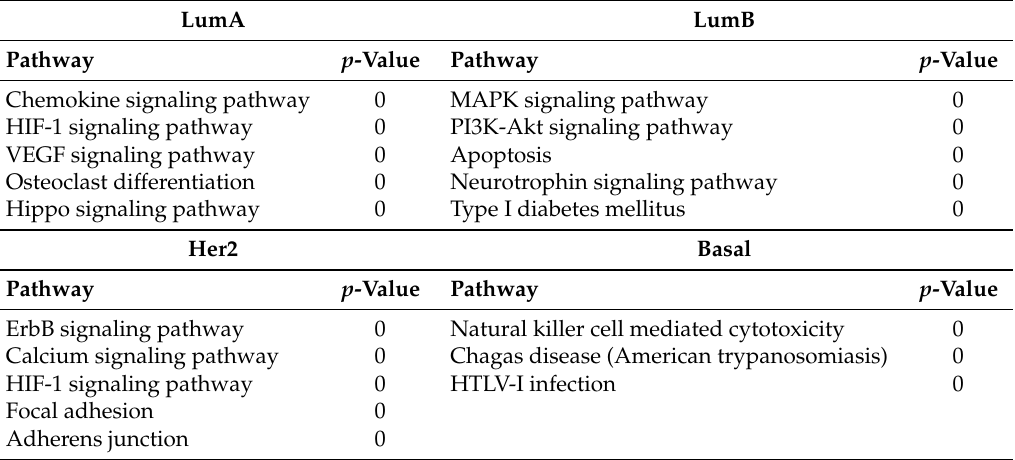
Table 4. Top-18 pathways obtained for breast cancer subtypes after enrichment performed by